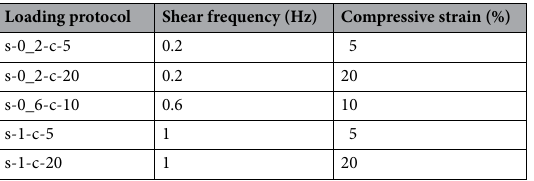
Table 1. Naming convention for the different loading protocols. s shear frequency, c compressive strain.